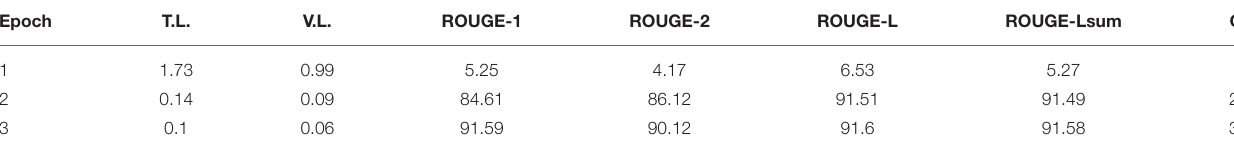
TABLE 6 | Fine-tuning T5 based on Equation 1. Epoch